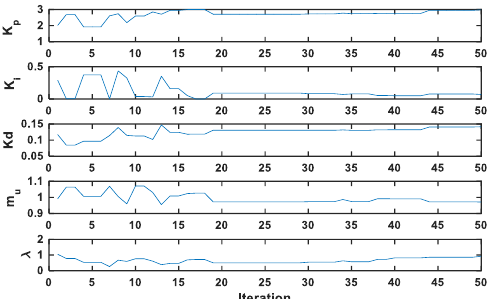
Figure 10. Corresponding control parameter trajectories of SI parameters versus